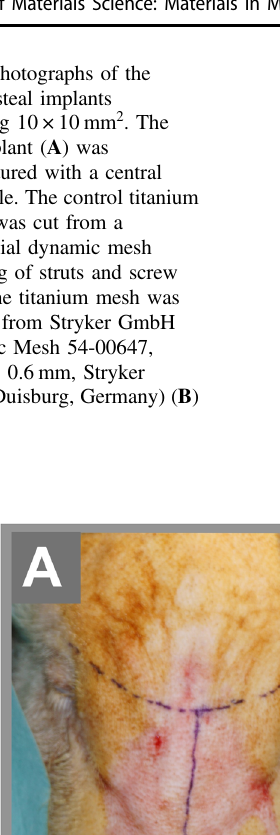
1.7 mm, length 5 mm). The intraosseous implantation was performed underneath the frontonasal suture on the thickest part of the nasal bone. A longitudinal osteotomy was prepared bilaterally using a rotating diamond-coated cutting disk. Titanium was inserted on the right side (white arrow), and NiTi was inserted on the left side (black arrow in B ). The intraosseous specimens were stable by friction forced. Wound closure was performed by a three-layer suture ( C )